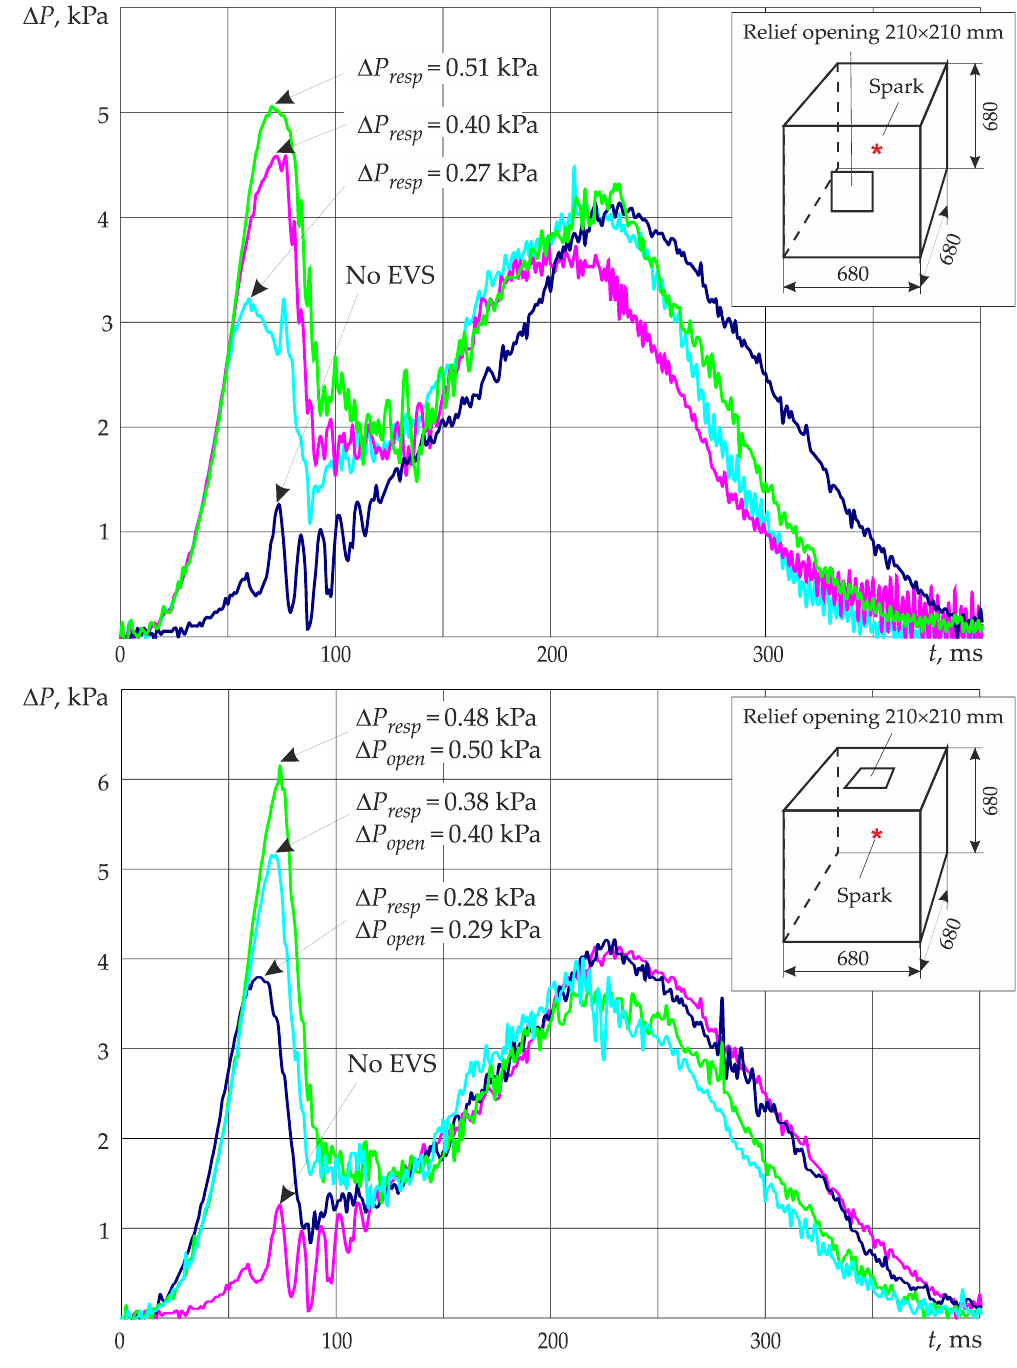
Figure 4. Experimental pressure waveforms in the case of a propane-air-mixture explosion in a spherical chamber ( h = 680 -mm).